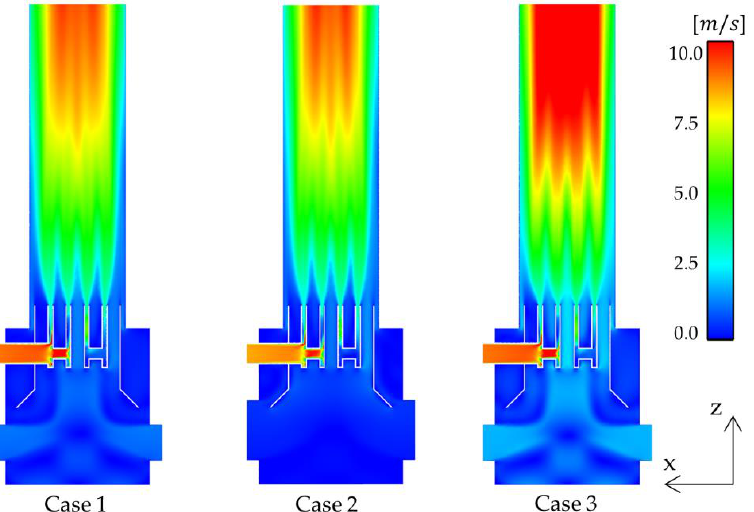
Figure 8. Comparison of the velocity distribution in the axial plane in different air inlet conditions ( y = 0).